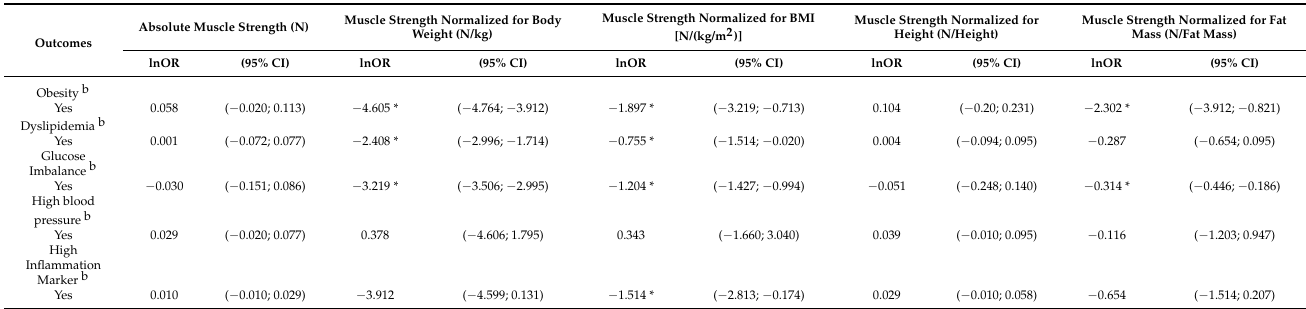
Table 2. Adjusted a association from binary logistic regression between muscle strength and cardiometabolic risk factors among females.